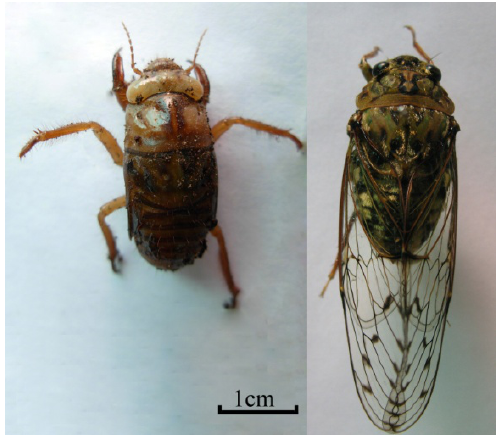
Figure 2. The nymph and adult of Oncotympana maculatieollis , as one host of C. cicadae , collected from Kunming in Yunnan (Pop